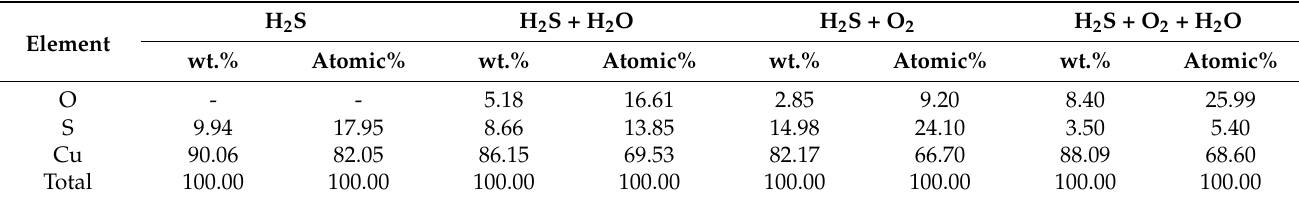
Table 3. The elemental content of corrosion products at four different corrosion